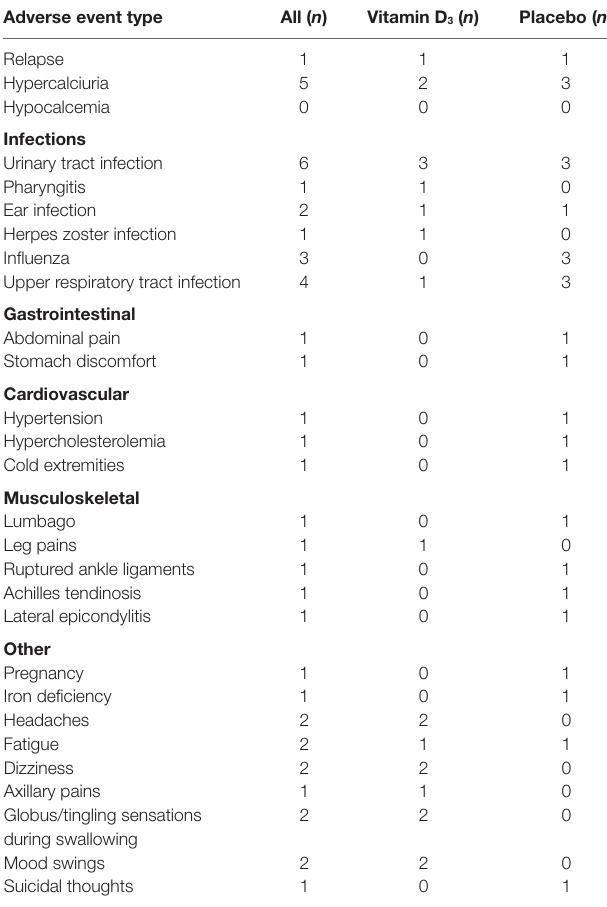
Table 2 | Overview of adverse events in participants who received the allocated intervention. adverse event